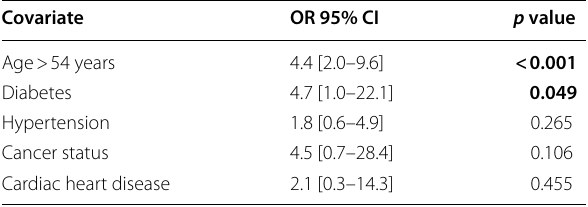
Table 3 Comorbidities associated with